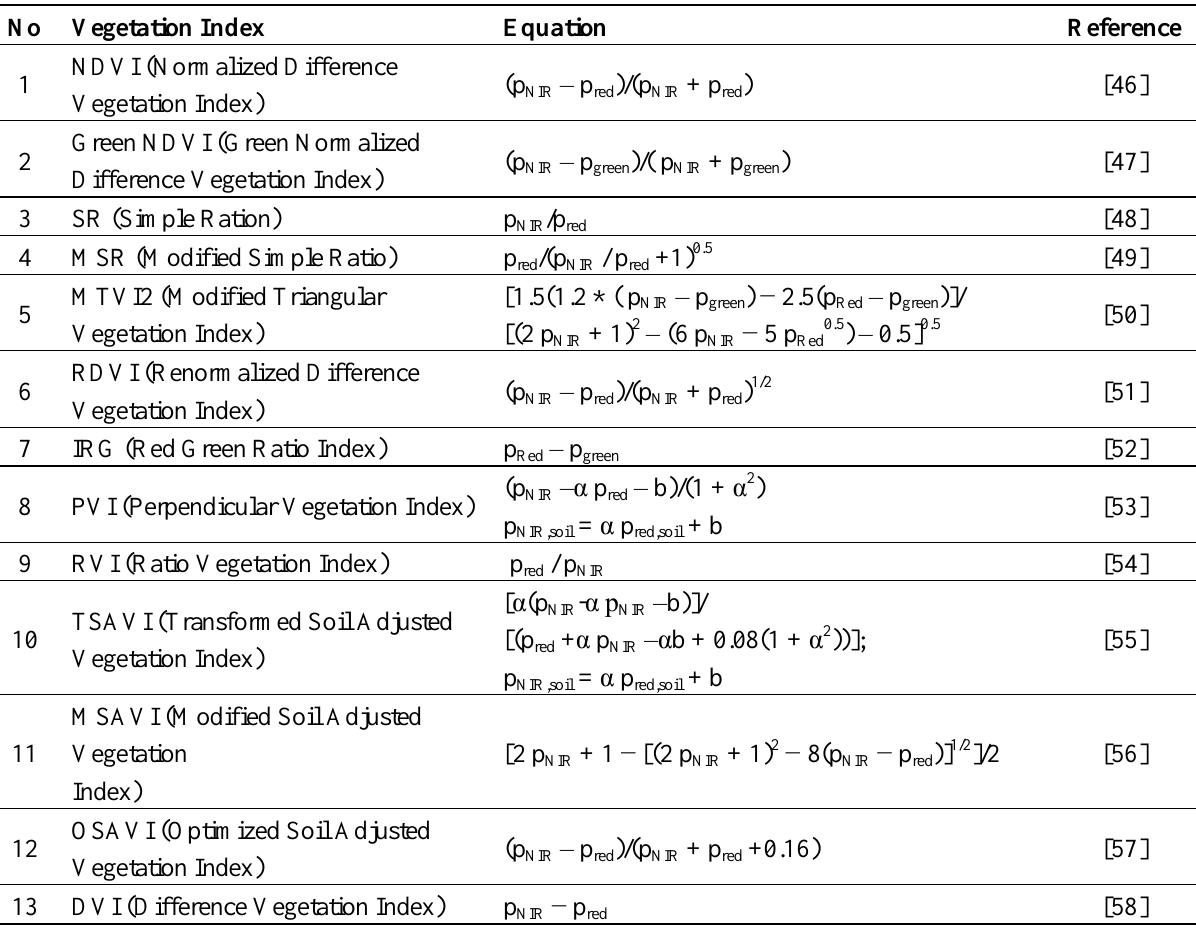
Table 2. Vegetation indices used in this